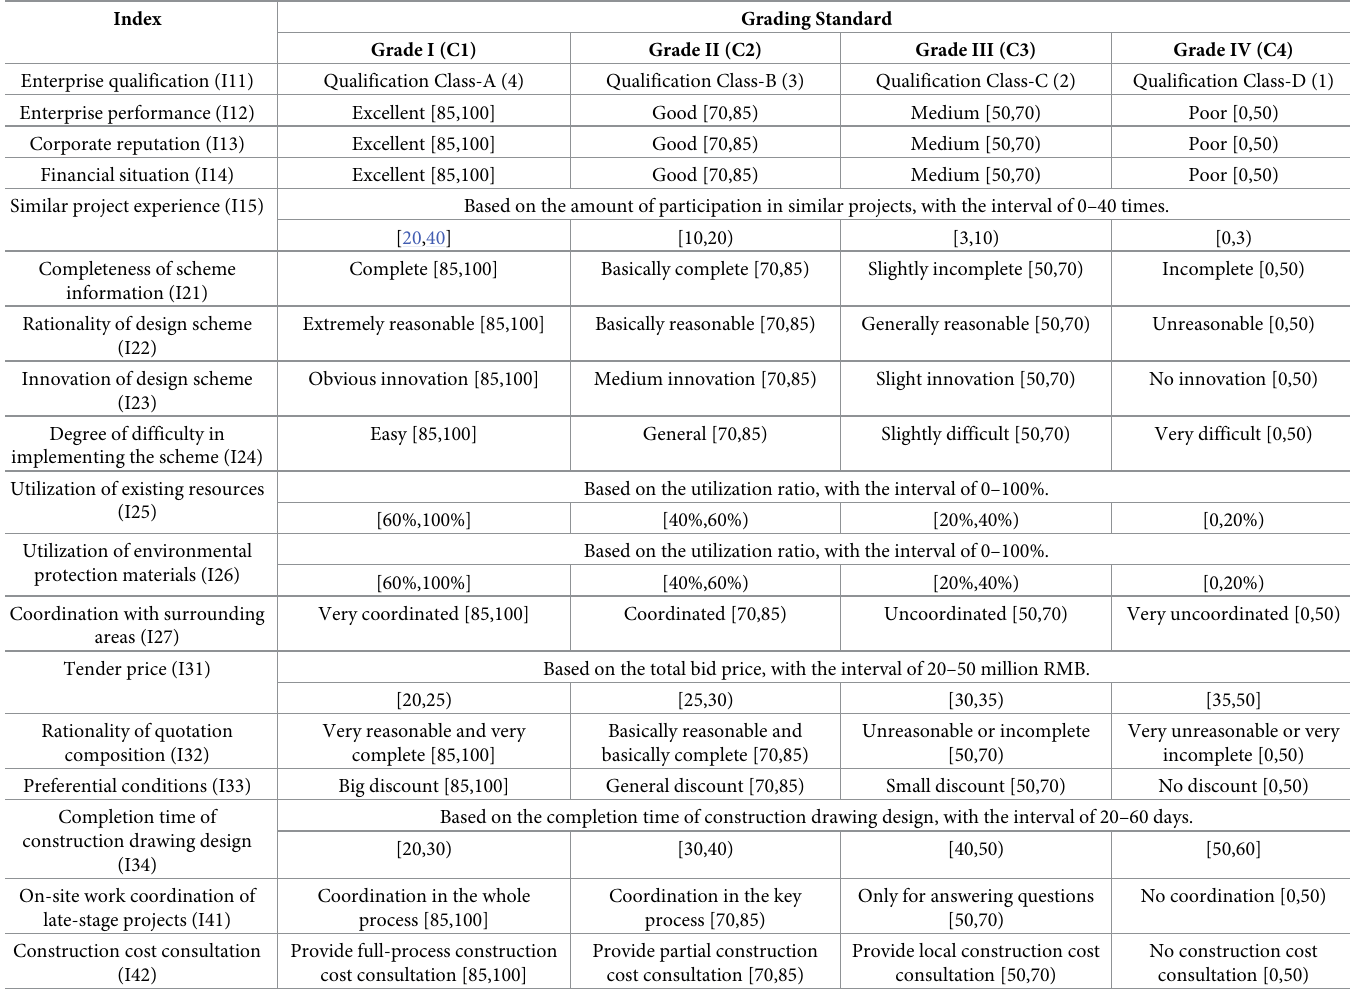
Table 1. Bid evaluation index grading standards for renovation project architectural